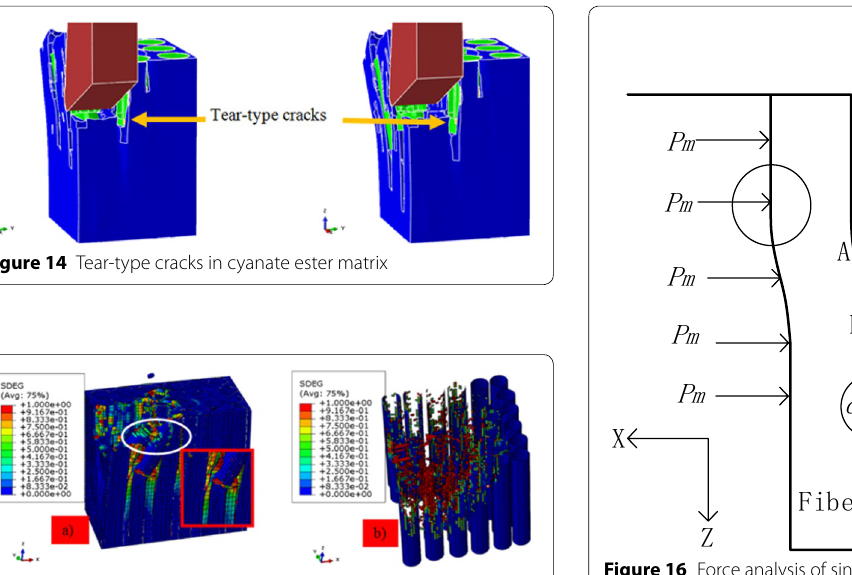
Figure 15 “Open” and “sliding” type cracks in interfacial phase